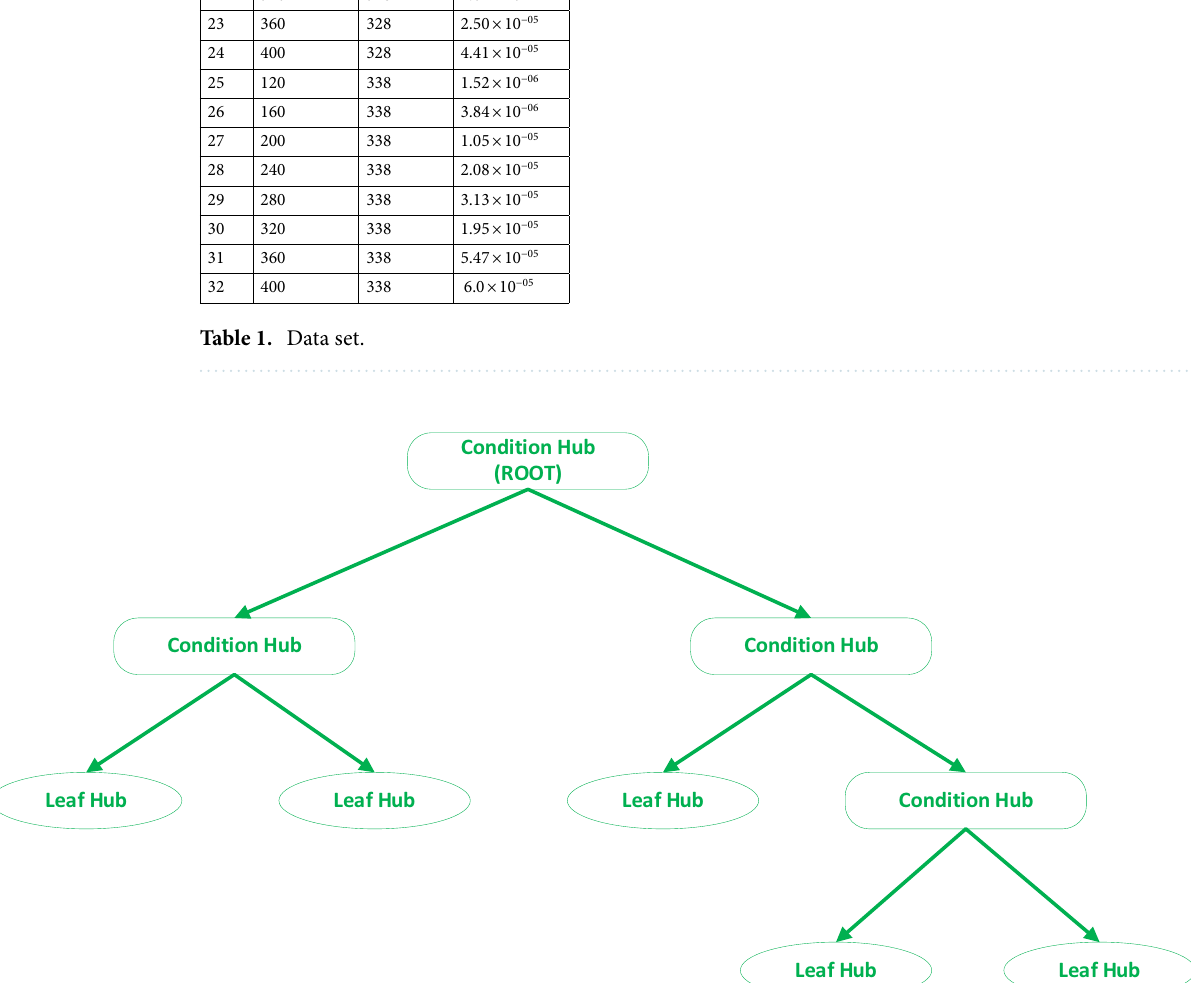
Figure 1. Decision tree sample